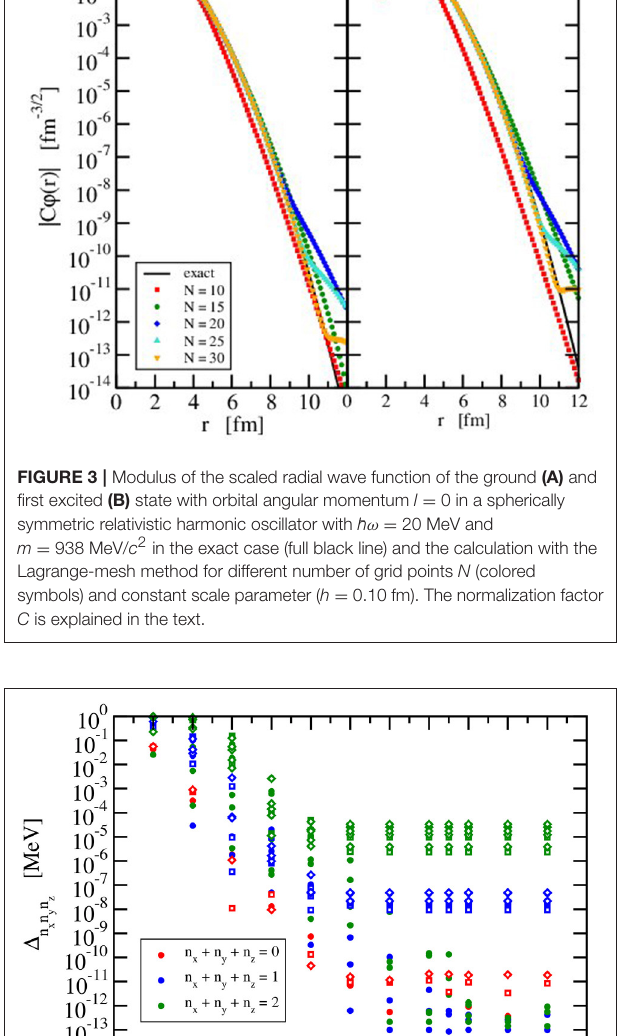
FIGURE 2 | Deviation (88) of the calculated lowest energies of a relativistic h ω harmonic oscillator with 20 MeV and m 938 MeV/ c 2 from the exact = = ¯ results for constant number of grid points ( N 25) and constant number of = channels ( N c 11). Results are shown as a function of the scaling factor h for = the spherical case (full symbols), prolate deformation with d 0.1 (open = diamonds), and oblate deformation with d 0.1 (open squares). = −